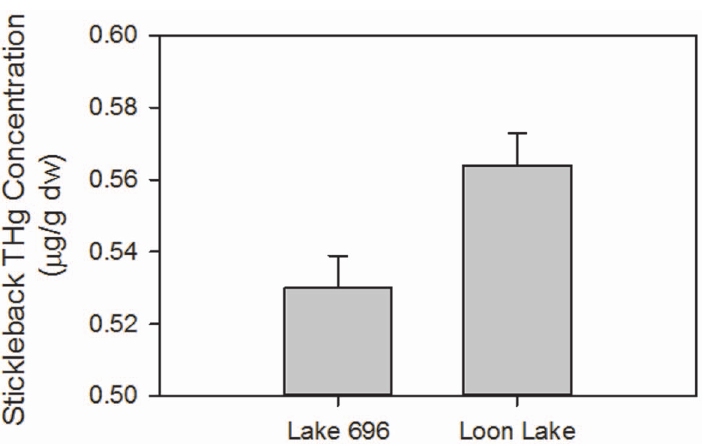
Figure 2. Total mercury (THg) concentrations in threespine stickleback collected from two lakes on Agattu Island in the Aleutian Archipelago, Alaska, 2011. Concentrations are reported as back-transformed least square means from the global mixed-effects model which accounts for other variables. Error bars represent 6 SE.